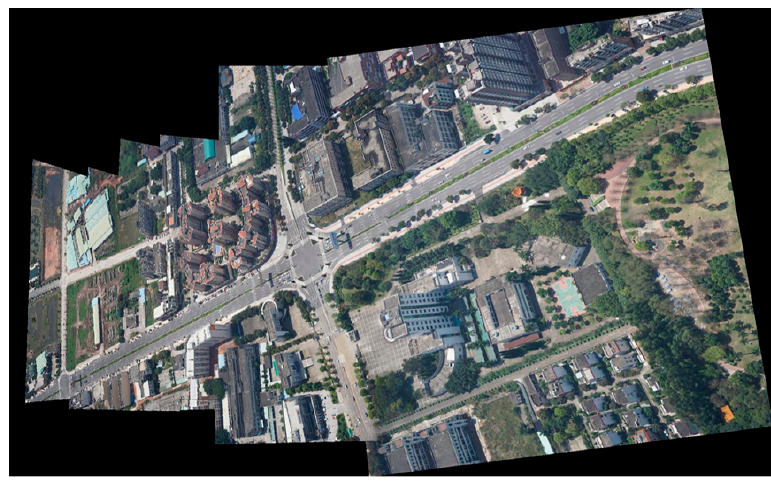
Figure 12. The stitching result of a single-strip image sequence.